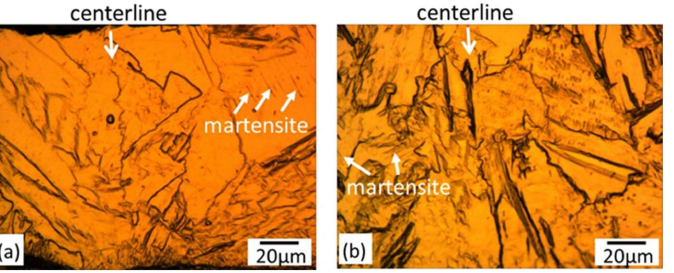
Figure 5. High magnification optical micrographs showing the weld centerlines and martensite ( α ’) phase on the ( a ) 100 µ m thick foil welded with 50 W of power and at a speed 20 mm/s, and the ( b ) 200 µ m thick foil welded with 100 W of power and at a speed of 30 mm/s.